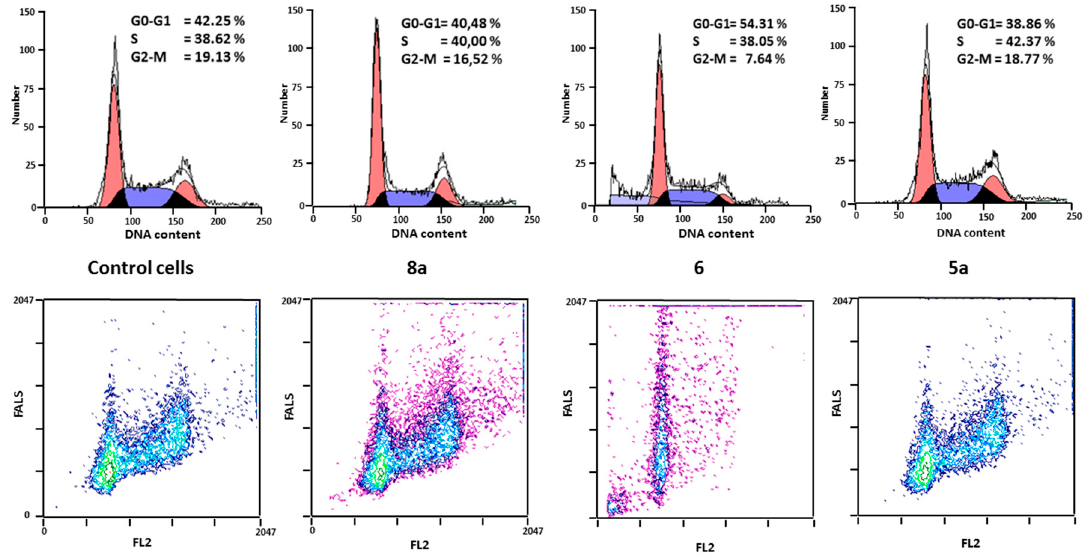
Figure 3. Flow cytometric assays of U2OS cells treated with compounds 5a, 6, and 8a , at the concentrations reported. In the upper row, the DNA distribution of a typical experiment in control and treated cells; the lower row indicates the biparametric cytograms of the DNA distribution (FL2) versus forward scatter (FAL signal. The compounds analyzed are reported between the two rows.